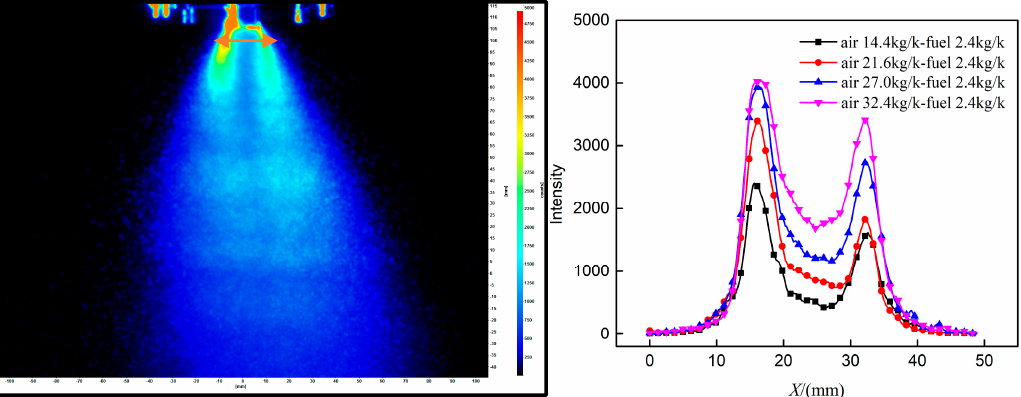
Figure 14. The influence of air mass rate on fuel distribution at a distance of 5 mm from the swirler exit in the y -direction (Case B).